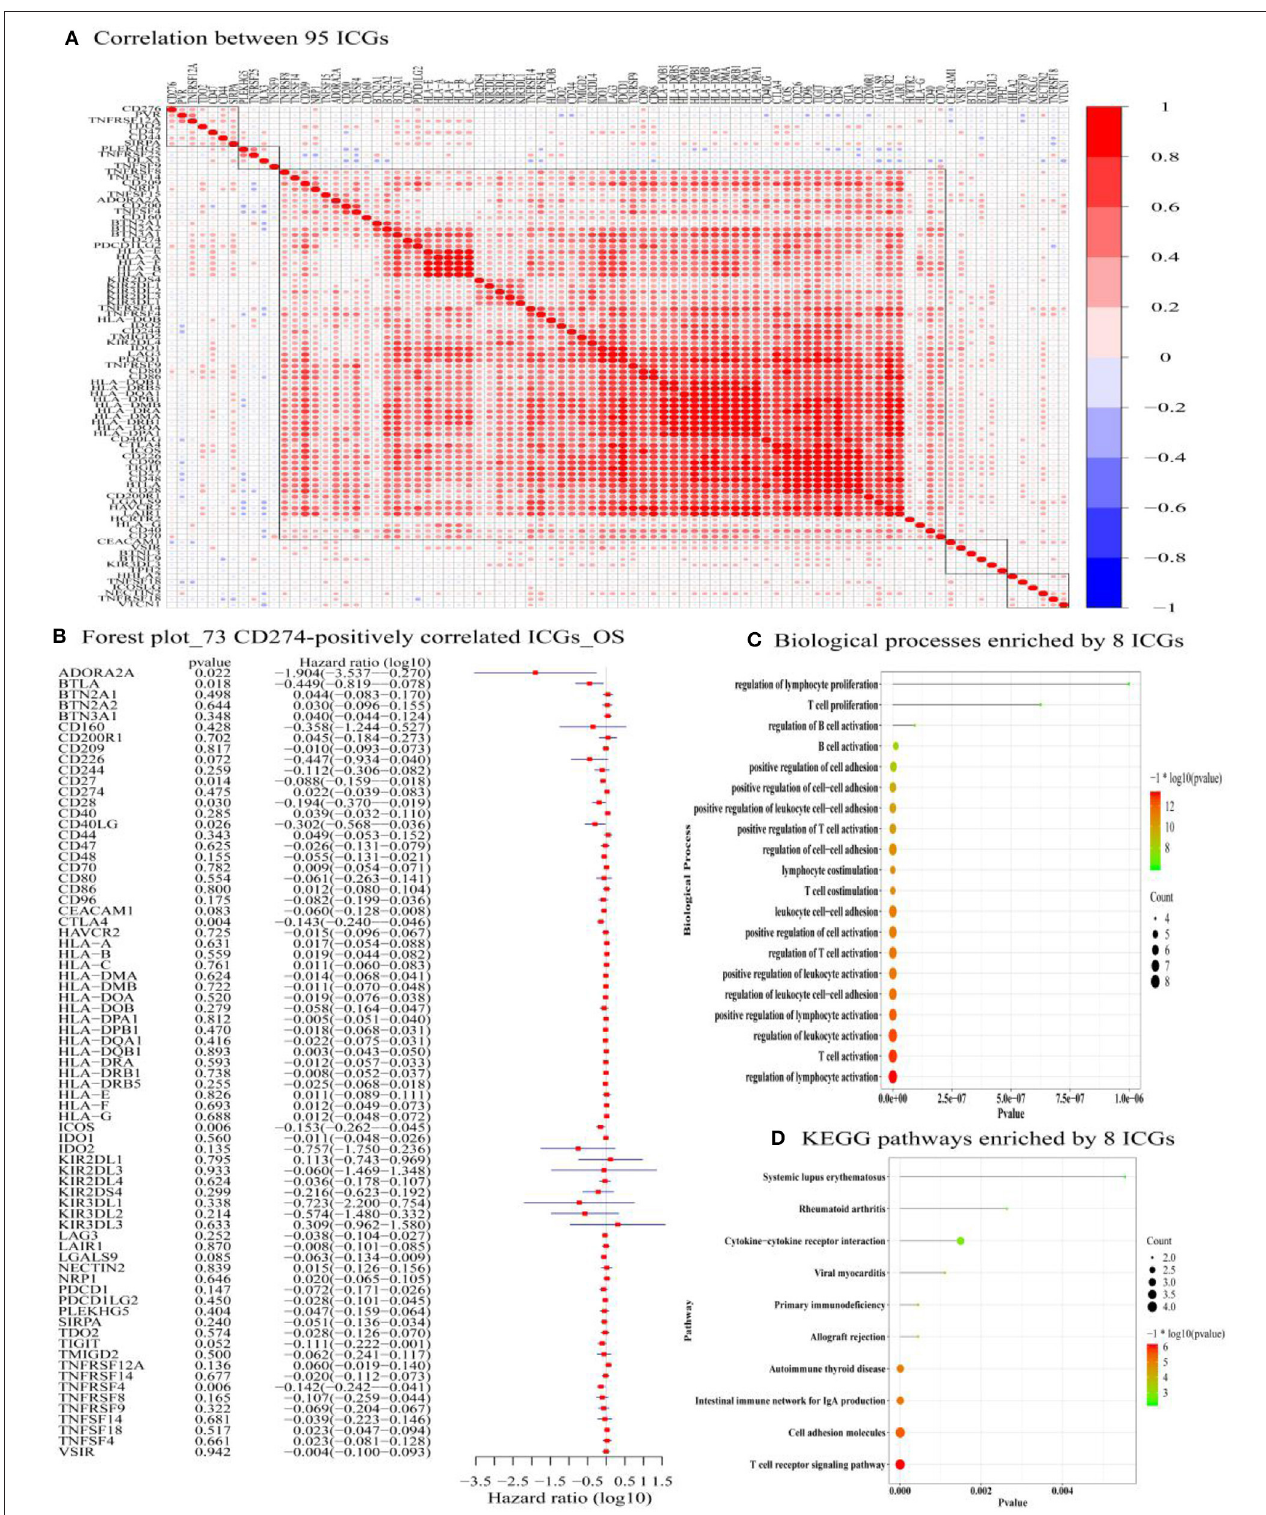
FIGURE 4 | The correlation between 95 ICGs and the prognostic values of 73 CD274-correalted ICGs. (A) The correlation between 95 ICGs. The index of the color bar indicates that the positively correlated ICGs (index > 0) and its negative correlation (index < 0). (B) The forest plot of log 10 hazard ratios (HRs) with 95% CIs shows the relationship between 73 CD274-positively correlated ICGs and overall survival (OS). The vertical line represents a HR of 0. (C) The Gene Ontology analysis